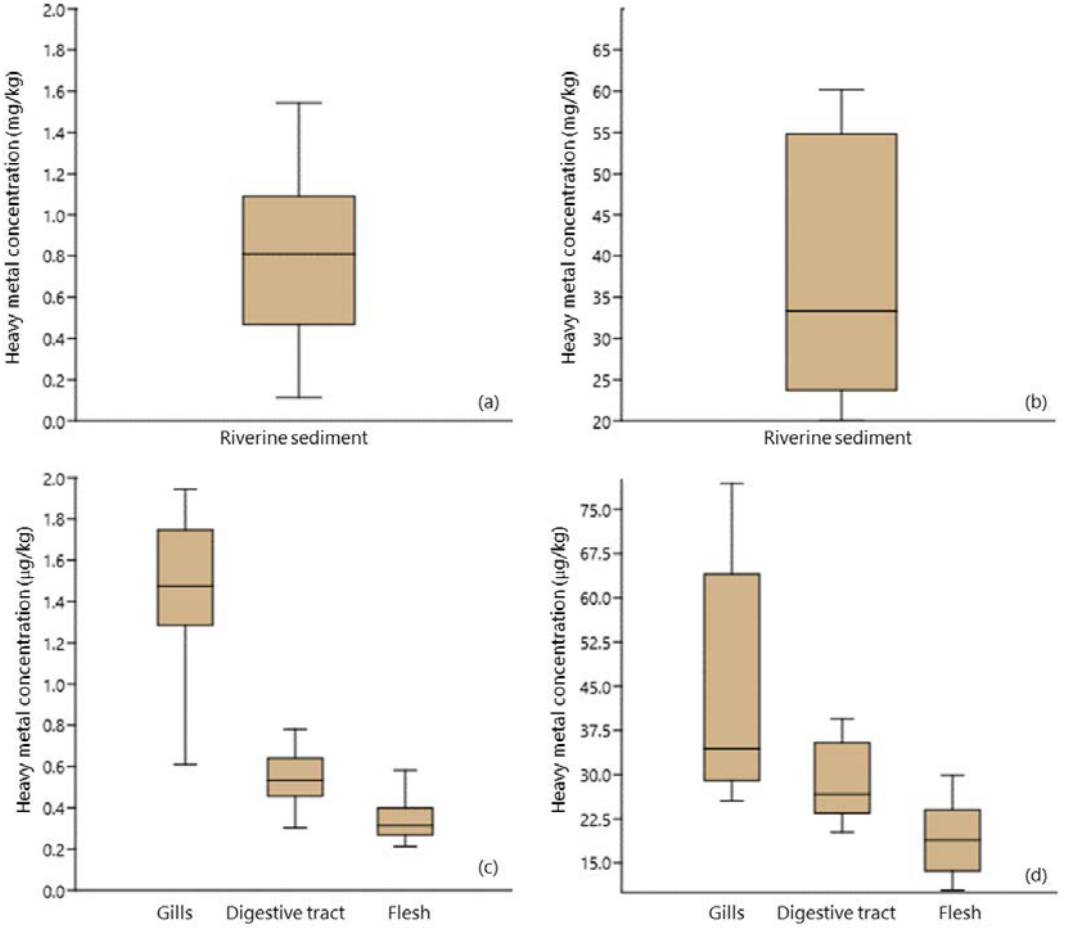
Fig. 2: The concentrations of Cd in the sediments (a), Pb in the sediments (b), Cd in the eels targeted organ (c), and Pb in the eels targeted organ (d) Table 1: Concentrations of Cd and Pb in Ciliwung River eels compared to several permissible standard limit Heavy